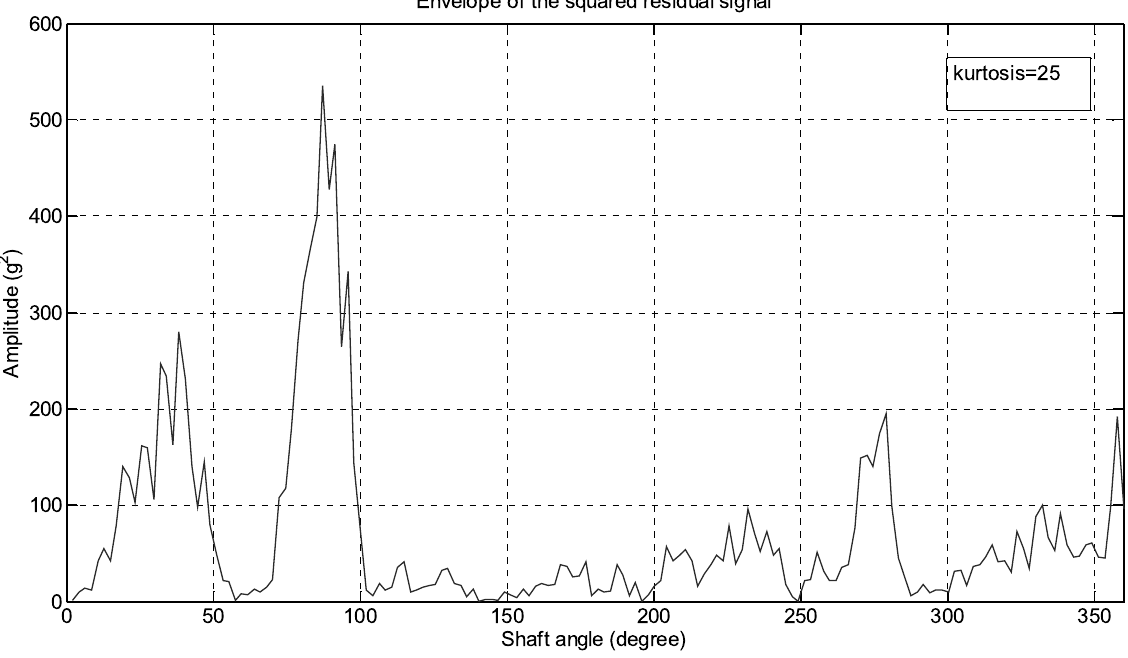
Fig. 20. Envelope of the squared residual signal in the time domain for 20% fault in the 7th harmonic.